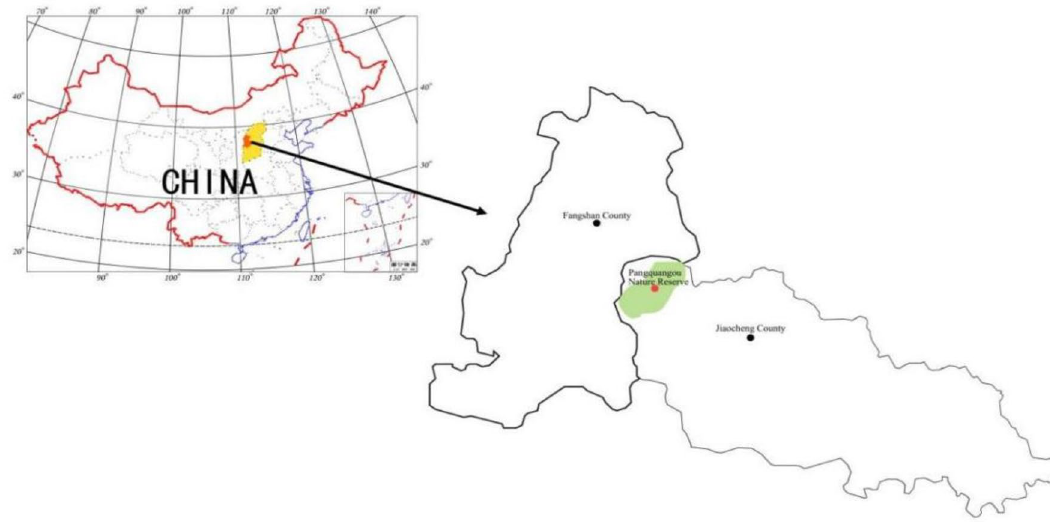
Figure 2. Geographical sites of Pangquangou Nature Reserve, showing geographical range and seed